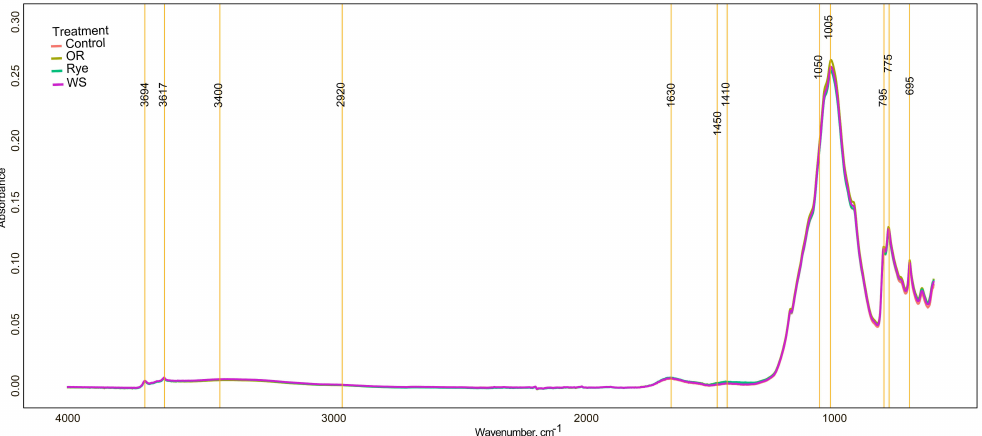
Figure 1. Average FTIR spectra obtained from analyses of the soil in each of four treatment conditions over a 105-day incubation period: soil only (Control), soil mixed with oilseed rape residues (OR), soil mixed with rye residues (Rye), and soil mixed with wheat straw